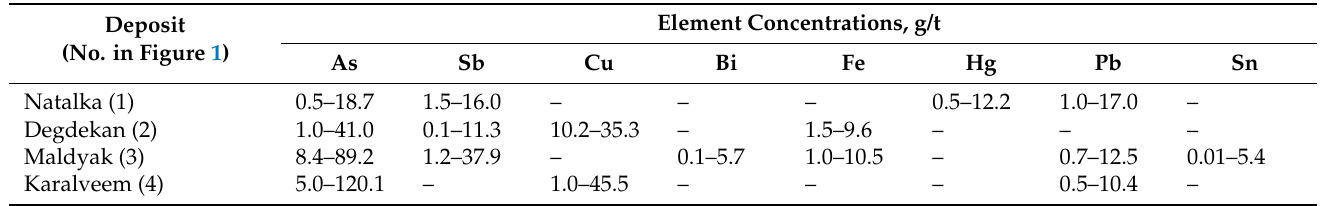
Table 1. Concentration of microimpurities in native gold from ores of gold–arsenic-sulfide GIT